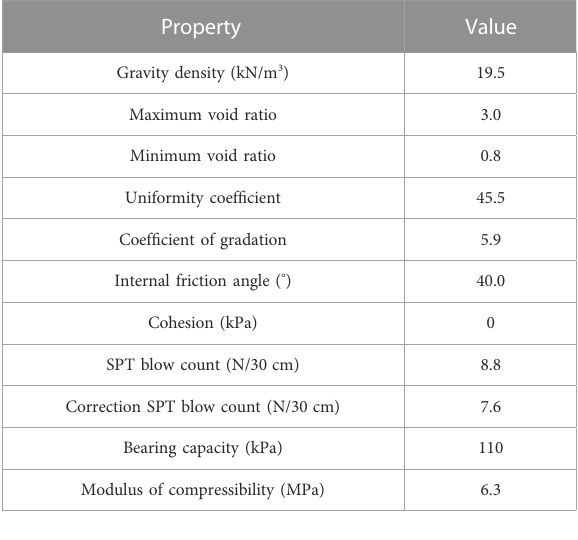
TABLE 1 Properties of the coral sands.